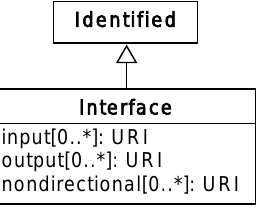
Figure 14: Diagram of the Interface class and its associated